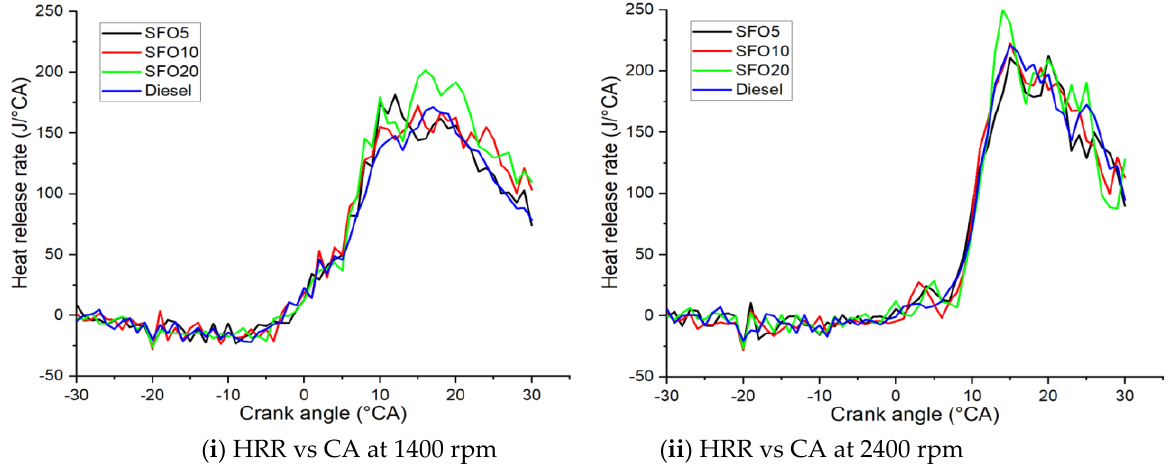
Figure 9. The variations in HRR for SFO blends and diesel under 100% engine load at speeds of ( i ) 1400 rpm and ( ii ) 2400 rpm.